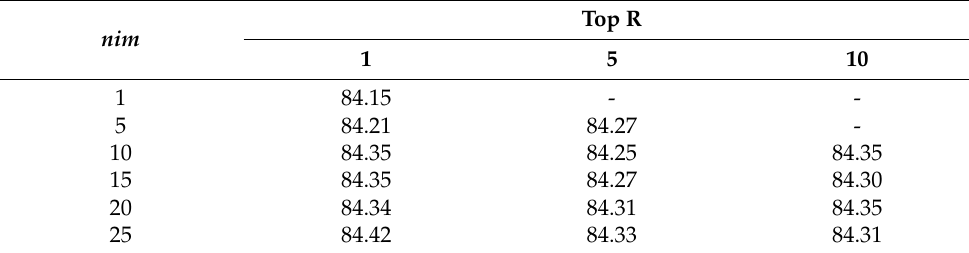
Table 1. Cumulative match characteristic (%) of selecting different returned Top